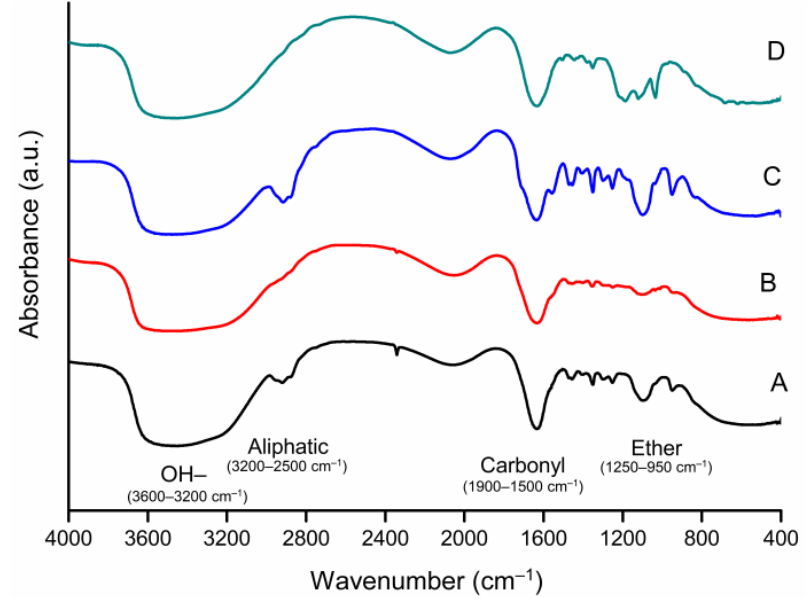
Figure 2. FTIR spectra of superplasticizers A, B, C and D.